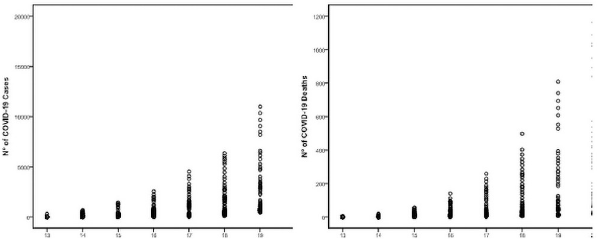
Fig 1. Temporal distribution of COVID-19 cases and their deaths in the capitals of the Northeast of Brazil. It shows the occurrence of distribution "front steps" motivated by speed and different magnitudes of contagion in the analyzed capitals.